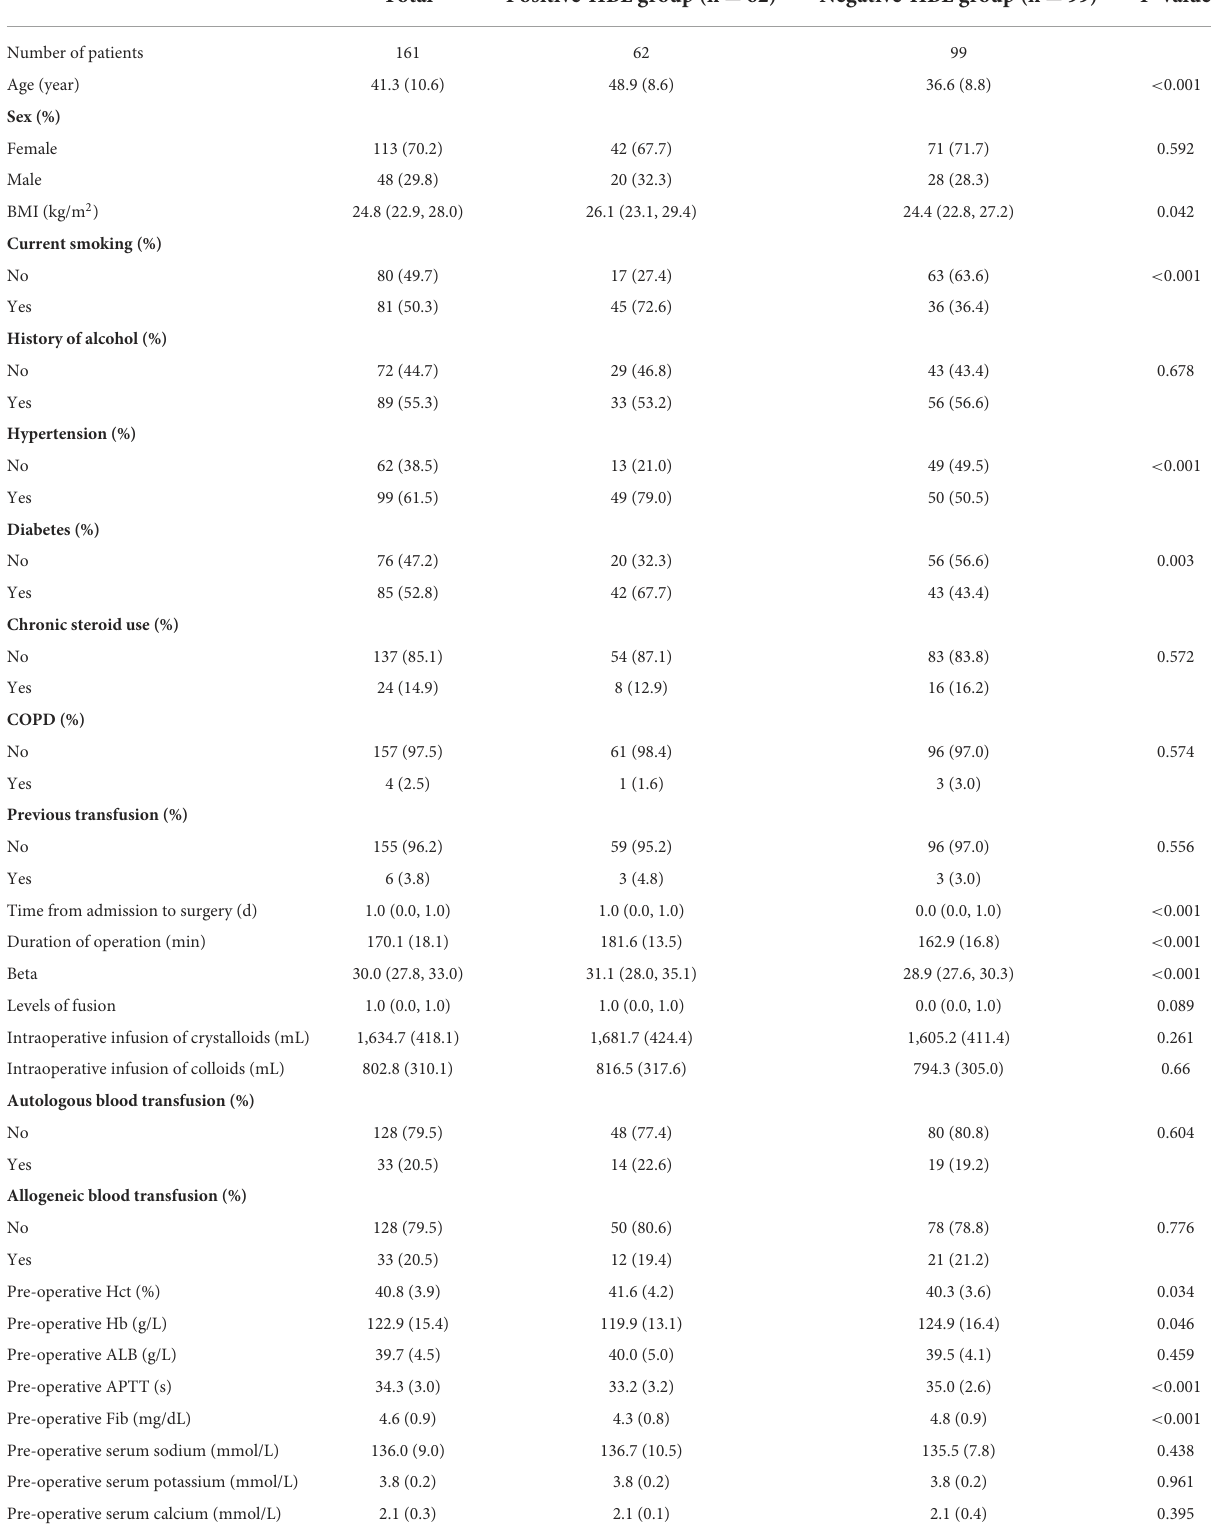
TABLE 1 Comparison of variables between the two groups.